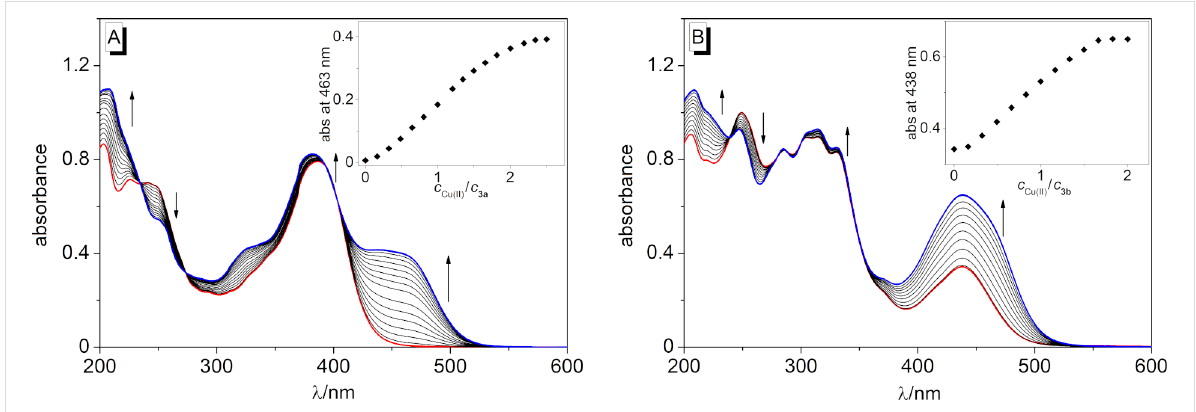
Figure 2: Spectrophotometric titration of 3a (A) and 3b (B) ( c = 20 µM) with Cu(BF 4 ) 2 ( c = 2.44 mM) in MeCN. Red: Spectra of solutions of 3a and 3b in the absence of metal ions; blue: spectra at the end of the titrations. The arrows indicate the changes of absorption upon the addition of Cu 2+ . Insets: Plot of the absorbance vs c Cu(II) / c 3a / b .